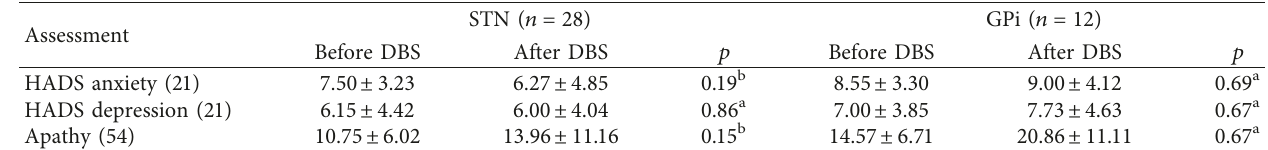
Table 6: Mood scores before and after